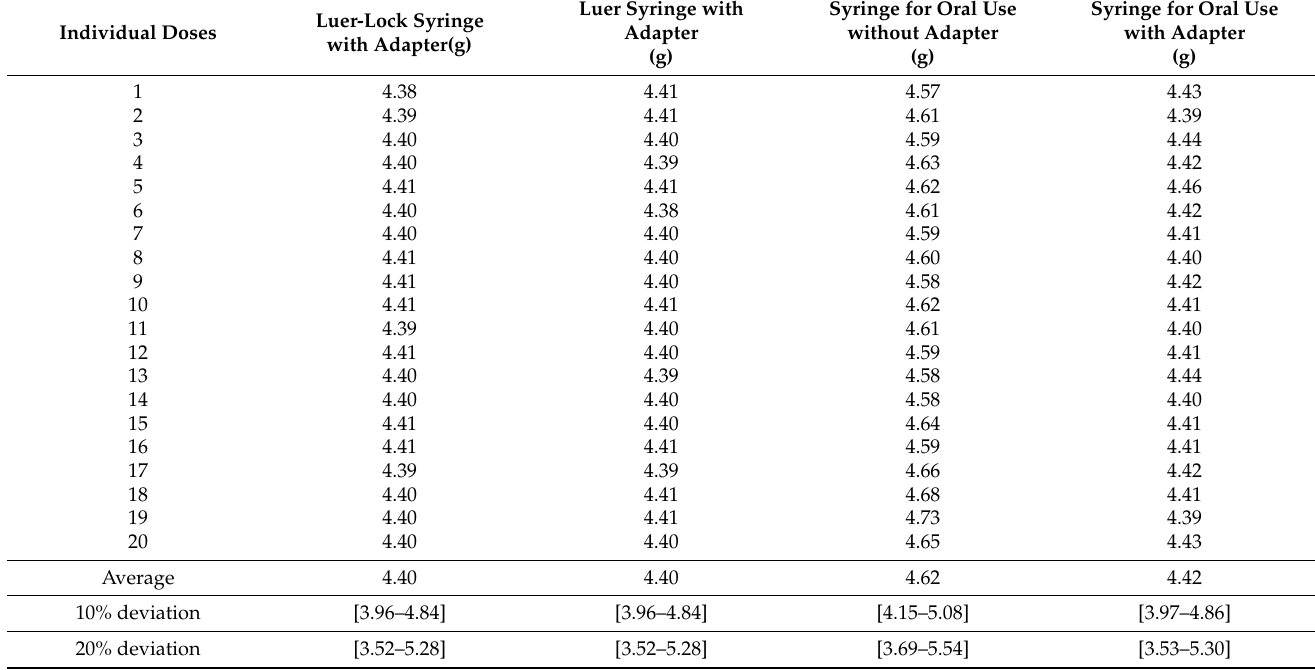
Table 6. Uniformity and accuracy of delivered doses from multidose